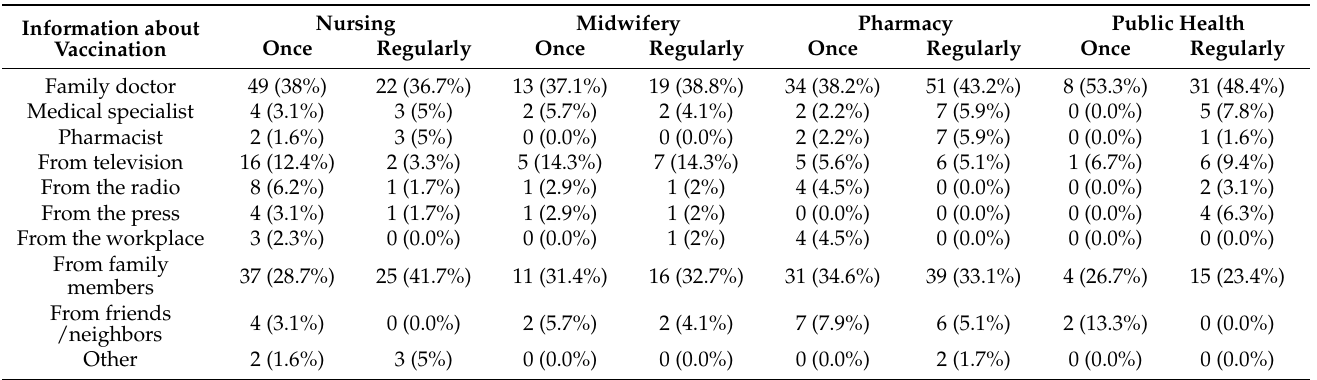
Table 5. The source of information about vaccination reported by students, according to major.